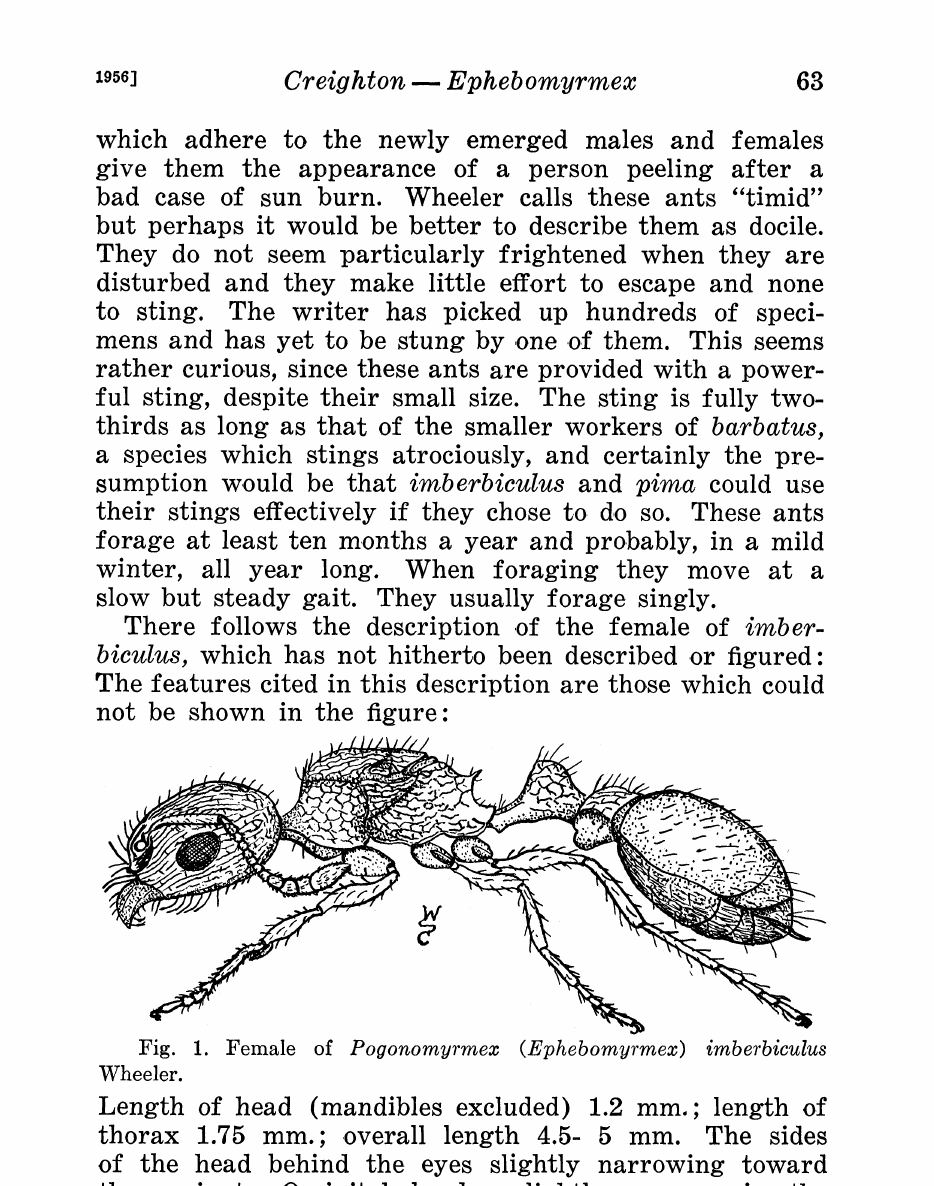
Fig. 1. Female of Pogonomyrmex (Ephebomyrmex) imberbiculus